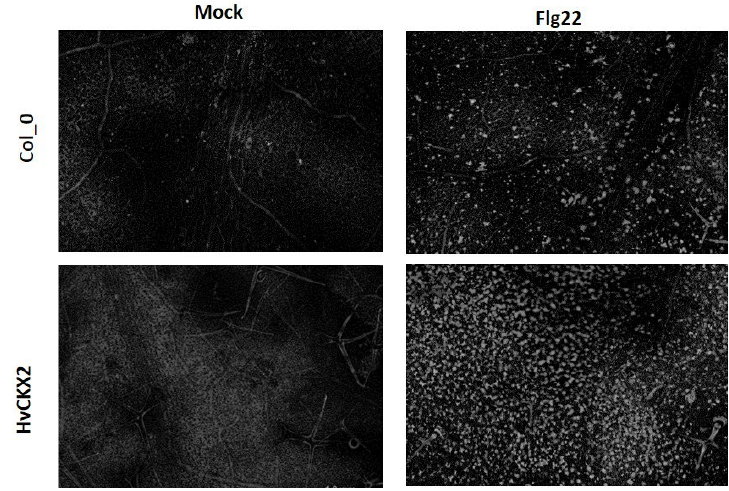
Figure 2. flg22-triggered callose deposition in the leaves of Arabidopsis Col-0 and HvCKX2 genotypes 24 h after treatment with 1 µM flg22 or ddH 2 O (mock).